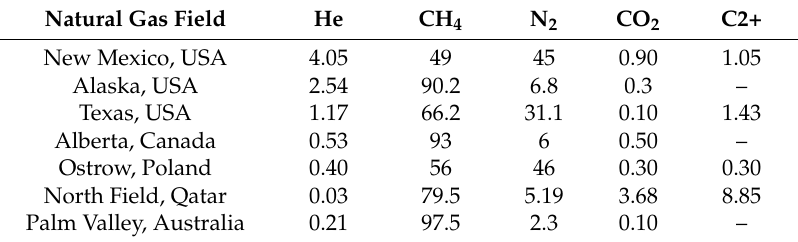
Table 1. List of helium-rich natural gas fields and their composition (mol %) [3,10]. Natural Gas